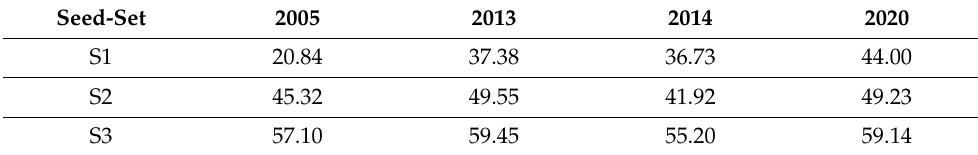
Table 4. Percentage of reproductive effectiveness (seed-set) for each year at the three sites